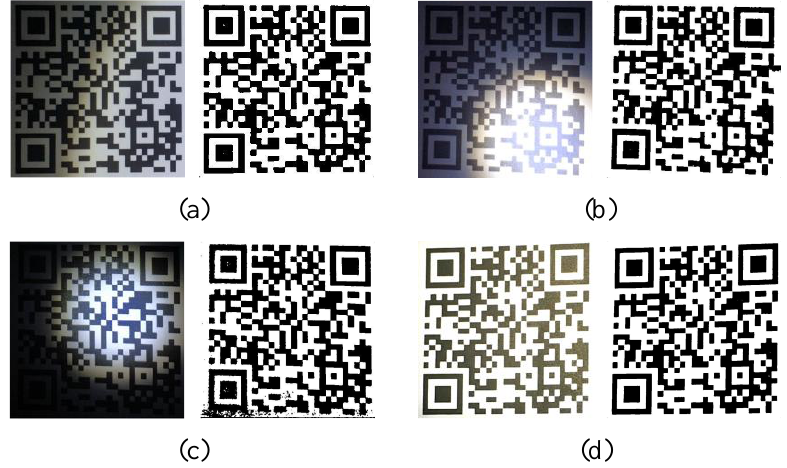
Figure 11. The original image and processing result: ( a ) 300 × 300; ( b )50 × 450; ( c ) 600 × 600; ( d ) 900 ×